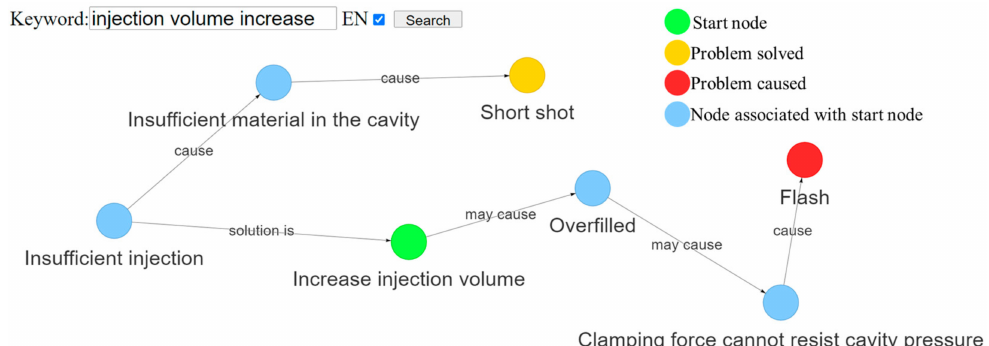
Figure 14. Action node search result.